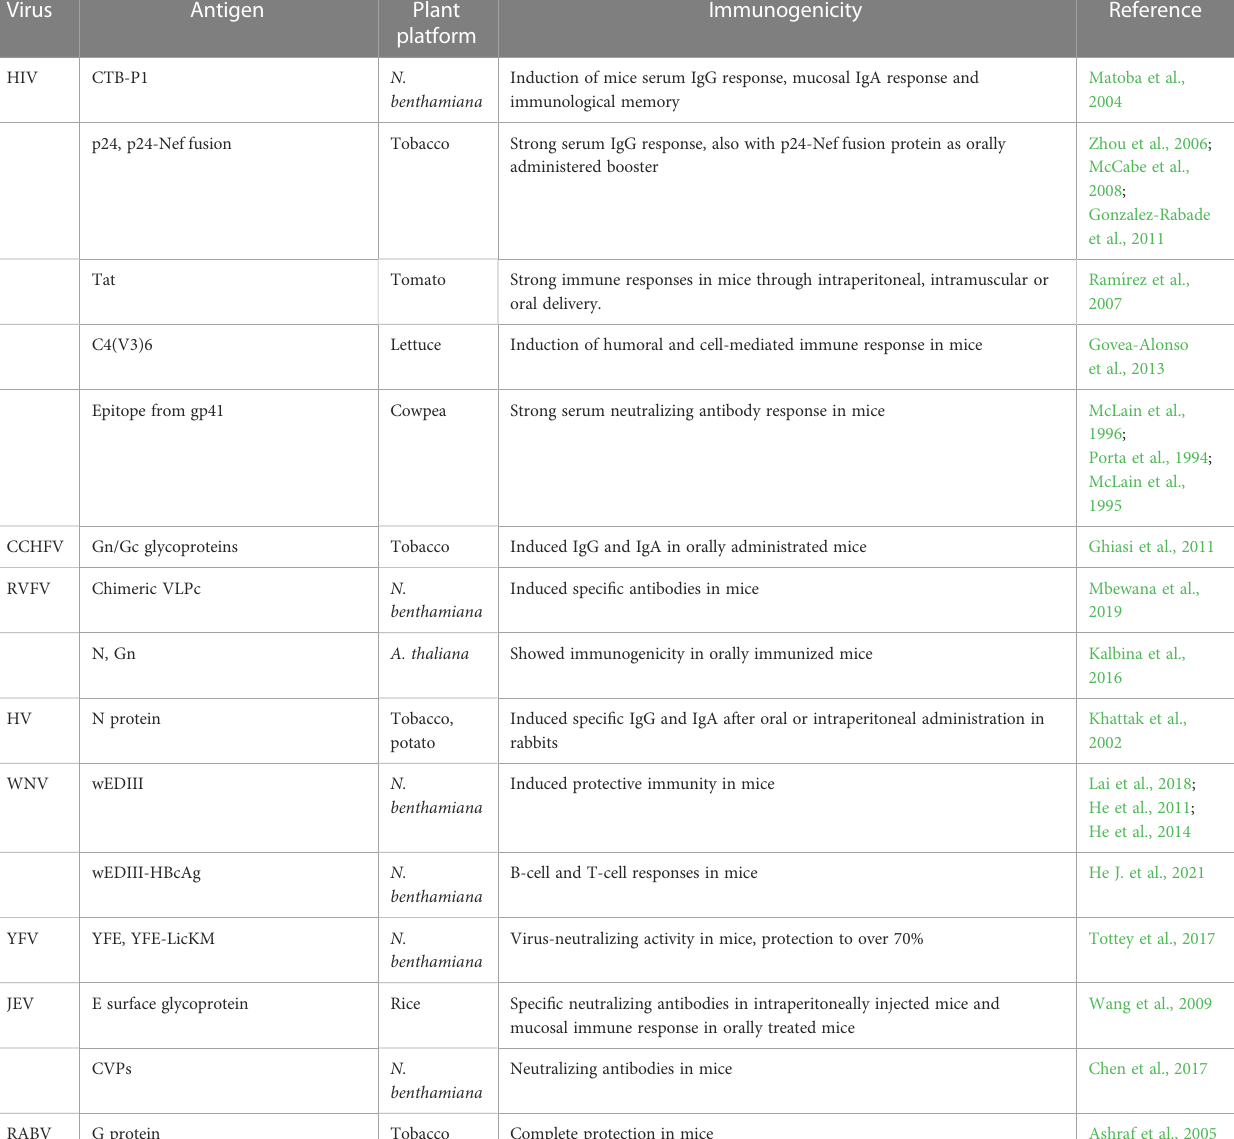
TABLE 2 Examples of plant produced antigens against zoonotic